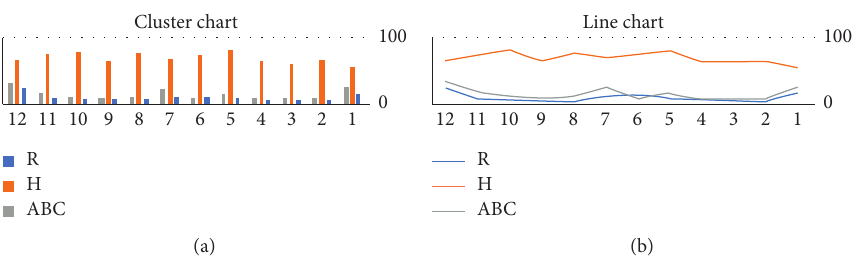
Figure 5: Cluster and line chart of ABC, R, and H.